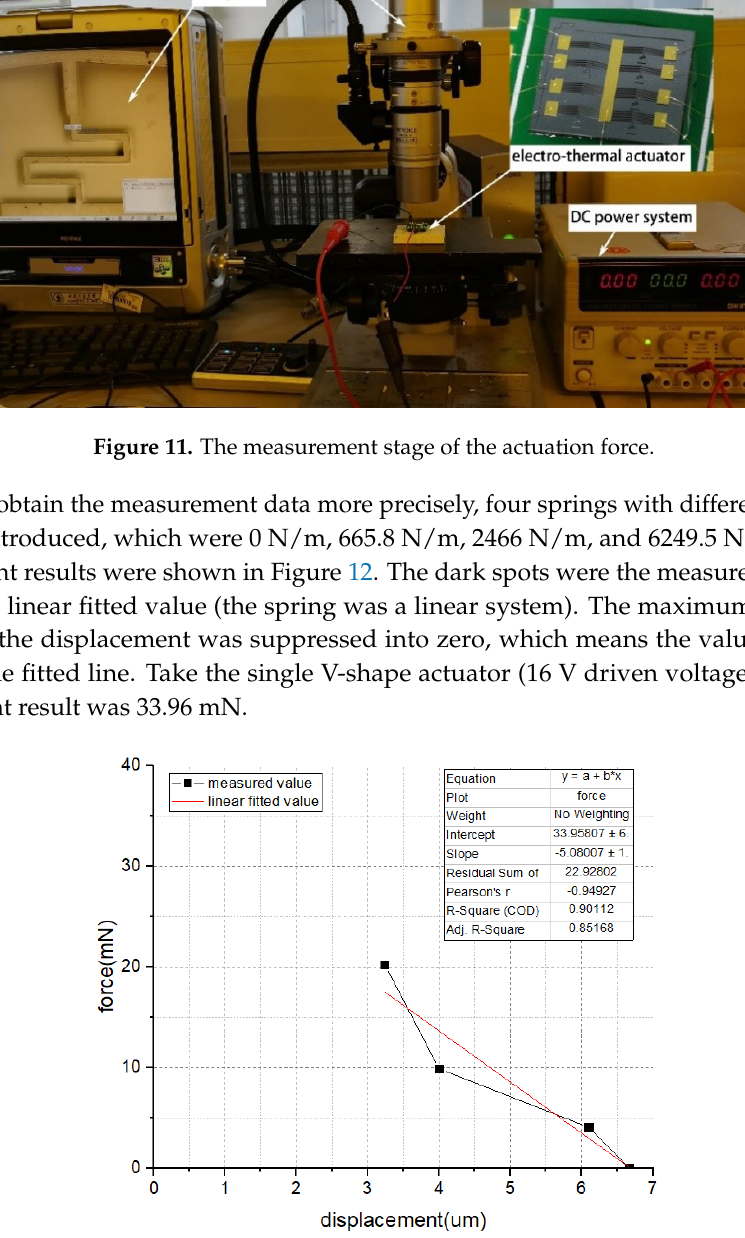
Figure 12. The measurement result of the actuation force (single V‑shape actuator).